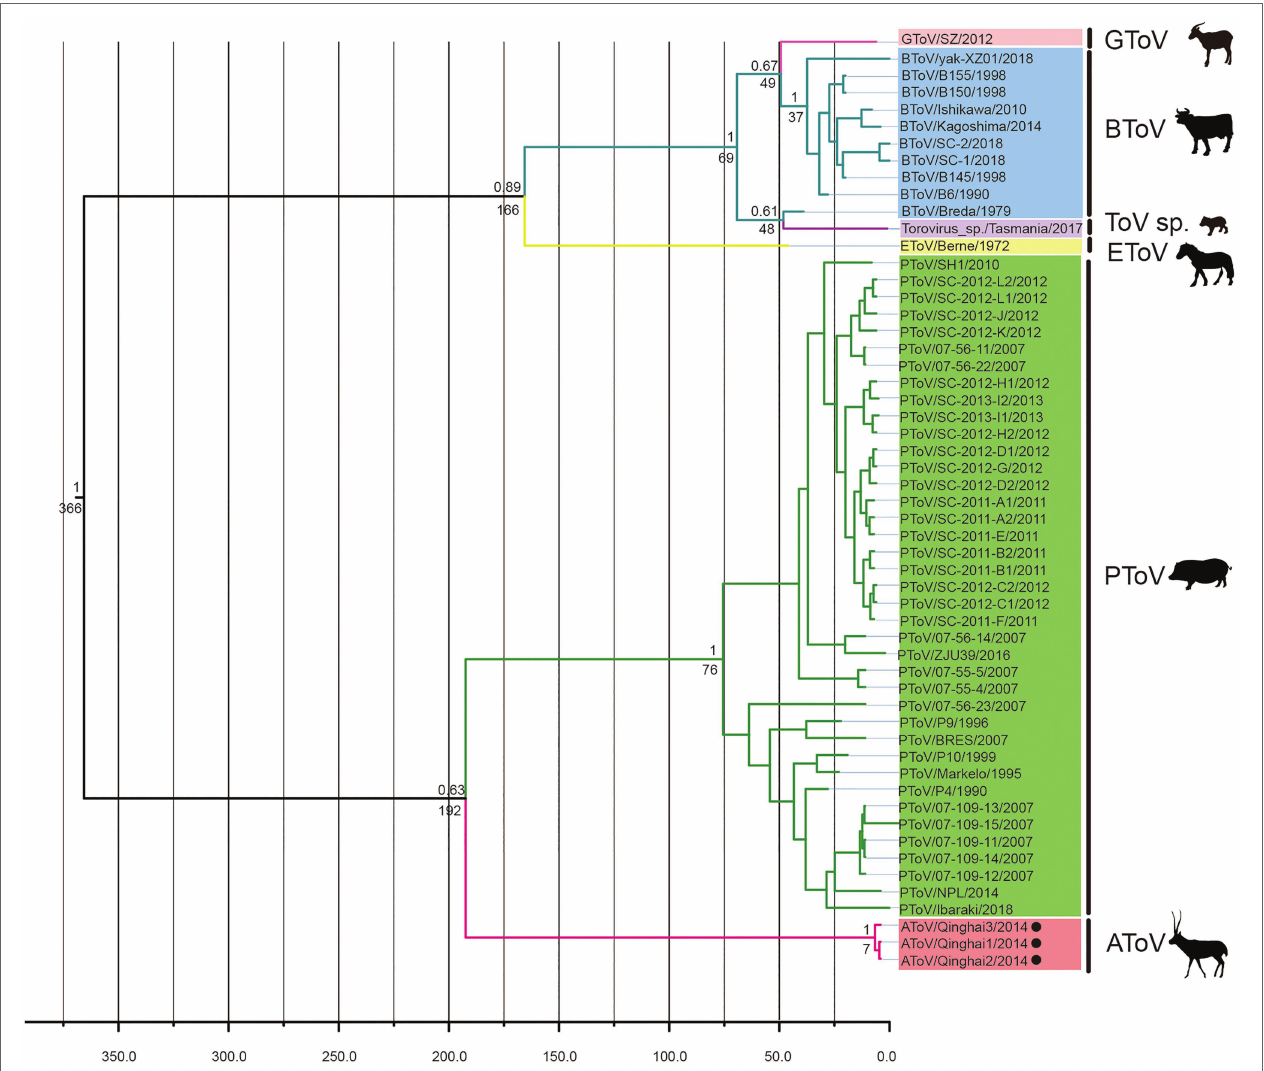
FIGURE 6 | The Bayesian maximum clade credibility tree of M genes of ToVs. The year of sampling, strain name, and virus species are on the tip labels. Node labels indicated the most recent common ancestor (tMRCA) and the posterior probabilities. Strains of AToV were marked with black